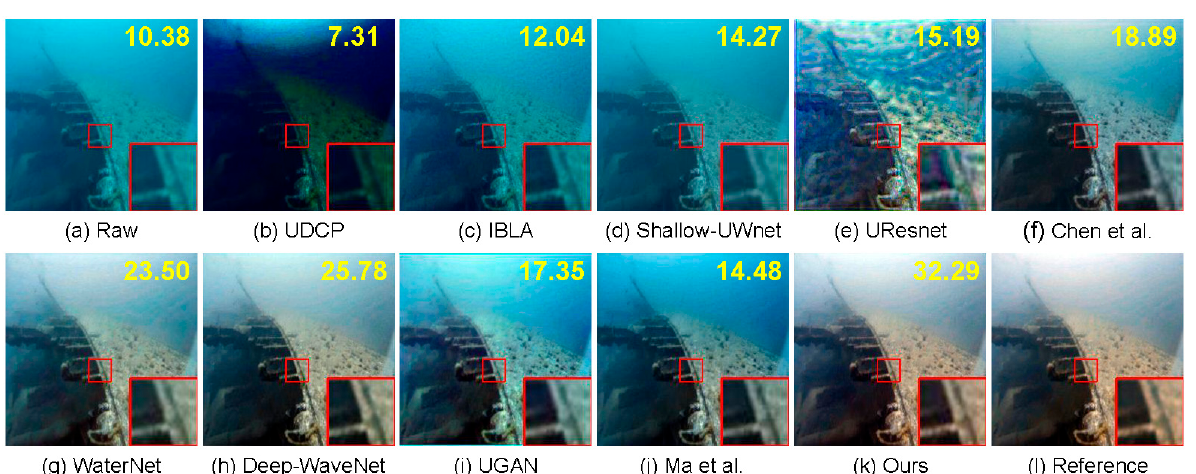
Figure 8. The visual comparisons of various UIE approaches on greenish underwater images. The number on each image represents its PSNR score.